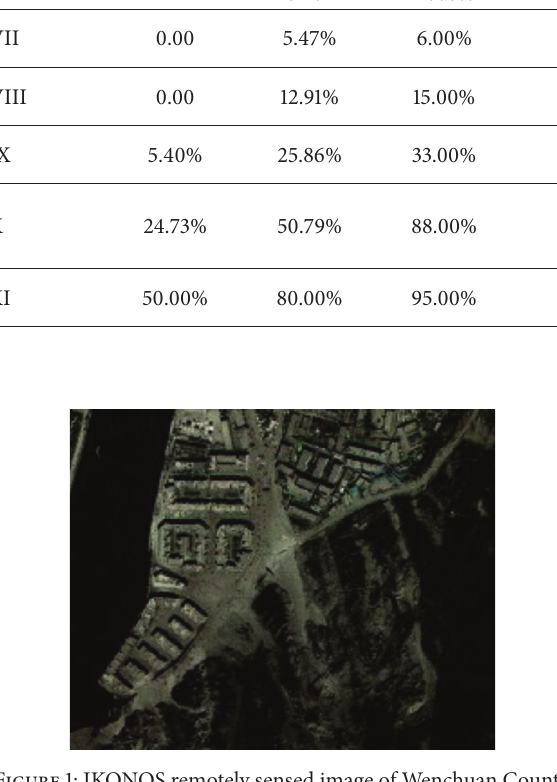
Figure 1: IKONOS remotely sensed image of Wenchuan County.